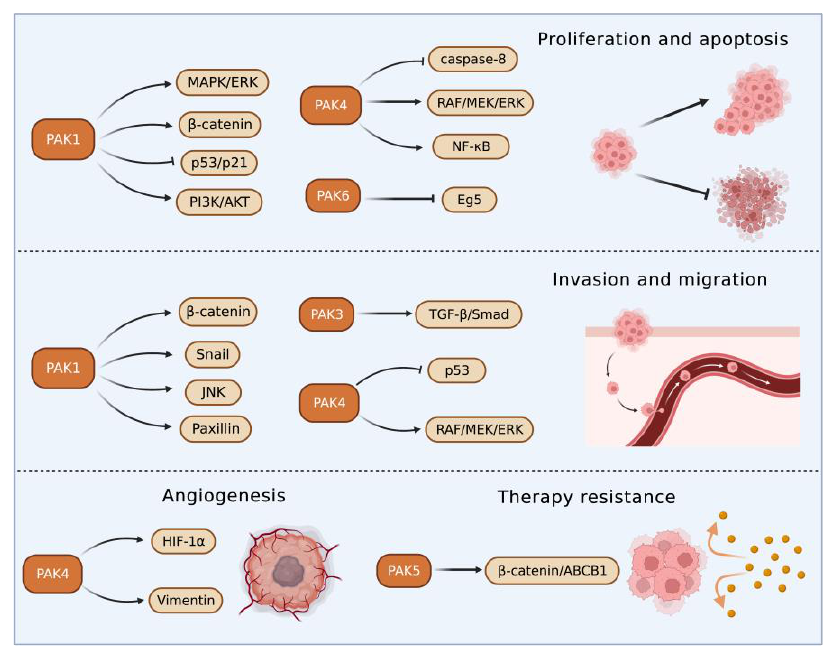
Figure 3. The pathways affected by PAKs in liver cancer. PAKs modulate multiple signaling path- ways (e.g. , RAF/MEK/ERK, β -catenin) to promote the proliferation, invasion/migration, angiogenesis, and therapy resistance of cancer cells while inhibiting apoptosis.